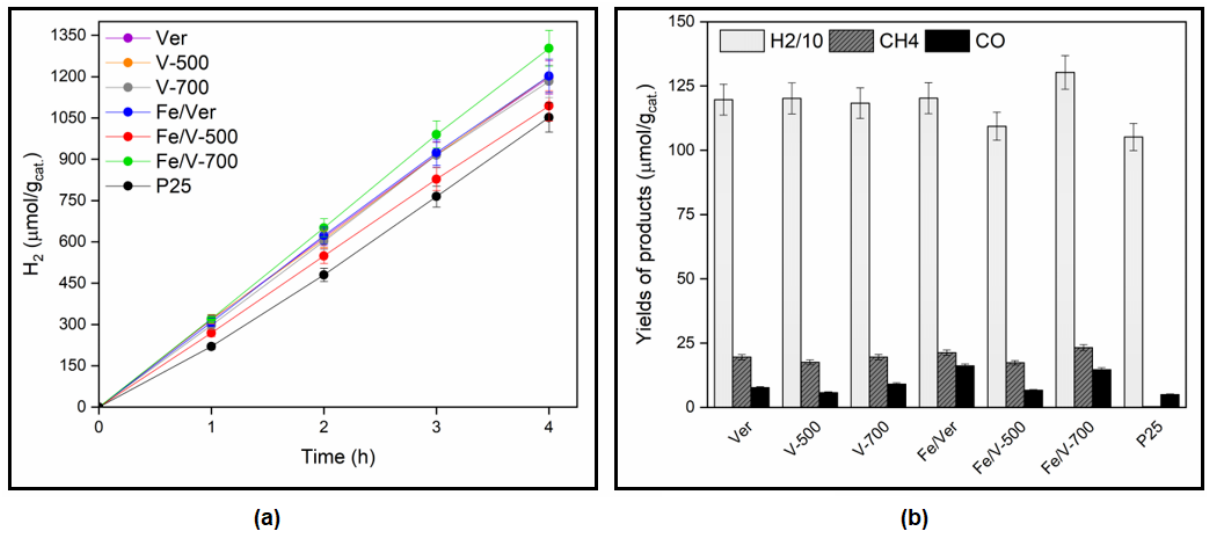
Figure 7. Photocatalytic hydrogen generation from the methanol–water mixture in the presence of vermiculite and Fe/vermiculite composite samples at 254 nm irradiation: ( a ) Time dependence on the yields of hydrogen and ( b ) Yields of H 2 , CH 4 and CO after 4 h of irradiation; P25 = commercial photocatalyst TiO 2 Evonik P25; H 2 /10 = yield divided by 10.